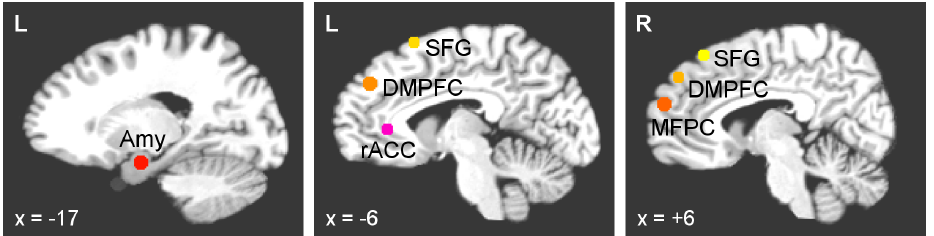
Figure 1 . Regions of interest for the effective connectivity analysis. Six brain regions exhibited a significant enhancement in functional connectivity with the left amygdala during the rtfMRI neurofeedback training with positive emotion induction [22]. They included: the left rostral anterior cingulate cortex (rACC, BA 24), bilateral dorsomedial prefrontal cortex (DMPFC, BA 9), bilateral superior frontal gyrus (SFG, BA 6,8), and right medial frontopolar cortex (MFPC, BA 10). The 10 mm diameter regions of interest (ROIs) in those areas are projected onto the standard anatomical template (TT_N27) in the stereotaxic array of Talairach and Tournoux [34].